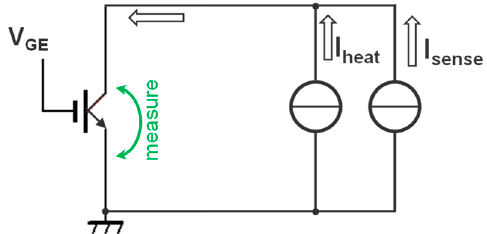
Figure 22. Measurement of an IGBT in saturation mode.